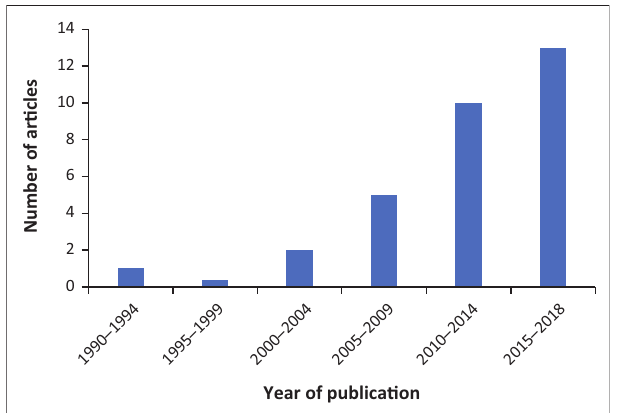
FIG URE 2: Number of articles reviewed and years of publication.